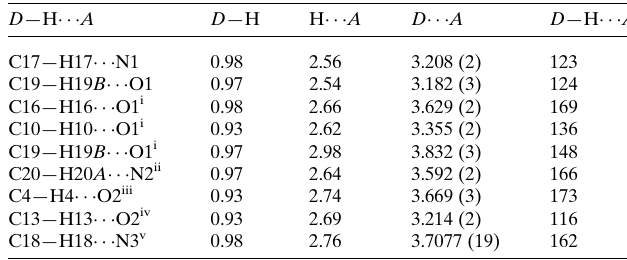
Table 1 Hydrogen-bond geometry (A˚ , (cid:2) ).